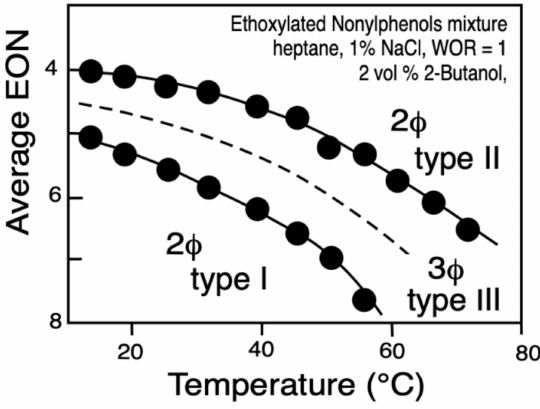
Figure 11. Variation of optimum formulation in the EON − T subspace with commercial mixtures of ethoxylated nonylphenols with EON = 4 and EON = 9 with a wide